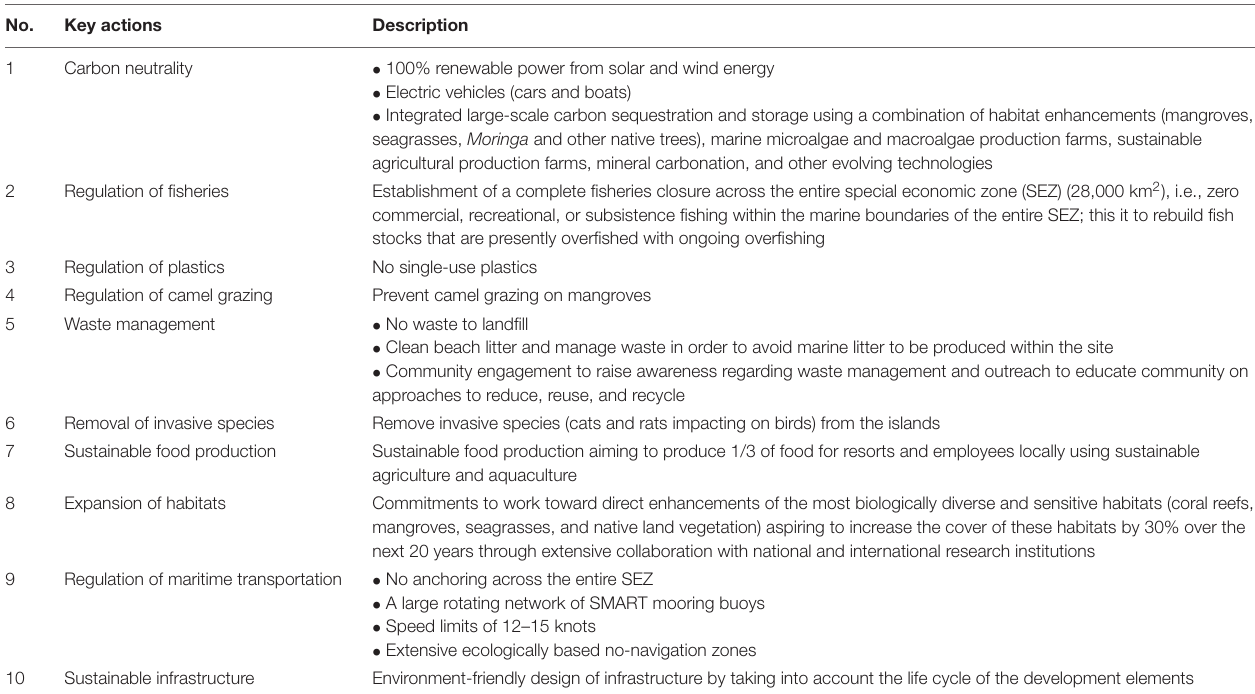
TABLE 3 | Ten key actions to be implemented by The Red Sea Development Company (TRSDC) to achieve net positive conservation benefits for The Red Sea Project area.